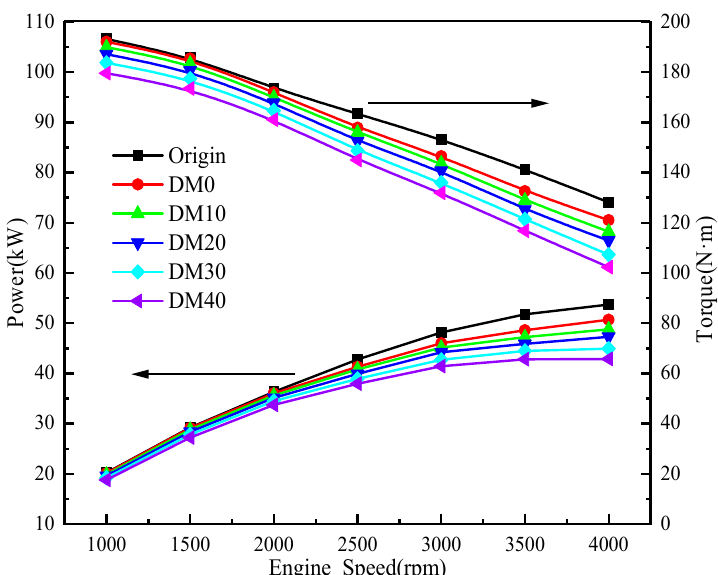
Figure 6. Effects of different ratios of methanol-diesel mixtures on engine power and torque at different speeds.